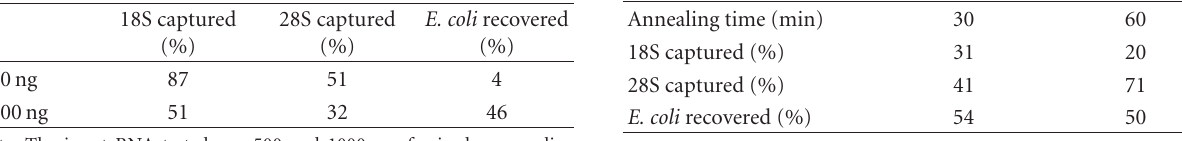
Table 3: Capture and recovery e ffi ciencies obtained by real-time RT-PCR. Capture was performed at 50 ◦ C using 500ng of input RNA (92.5% mammalian and 7.5% E. coli